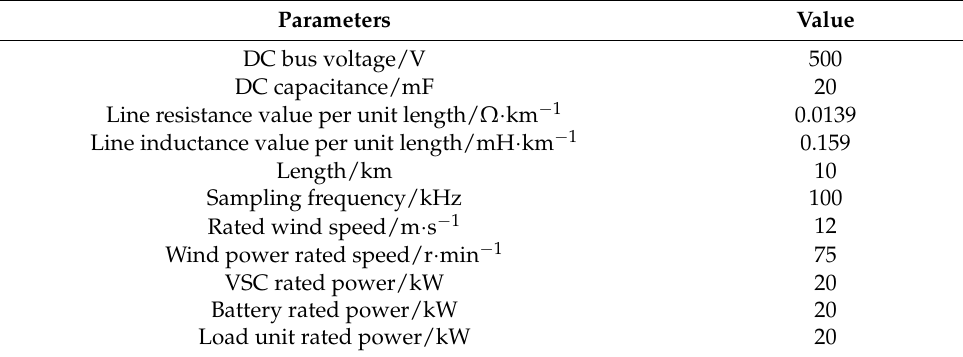
Table 2. Partial parameters of six-terminal DC distribution network system.